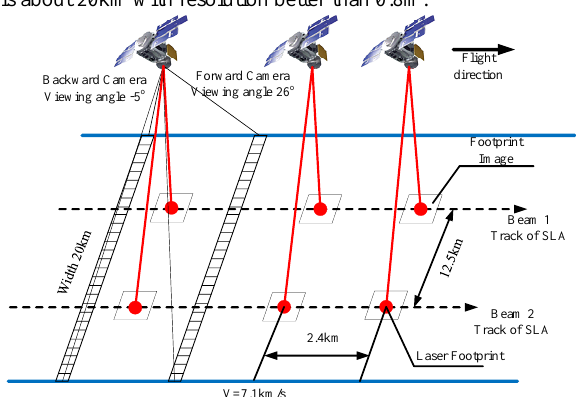
Figure 1. Working mode of GF-7 satellite And the inclination angle of two laser beams are about 0.7 degrees on the vertical plane along the left and right of nadir pointing direction respectively, and the laser wavelength is 1064nm,